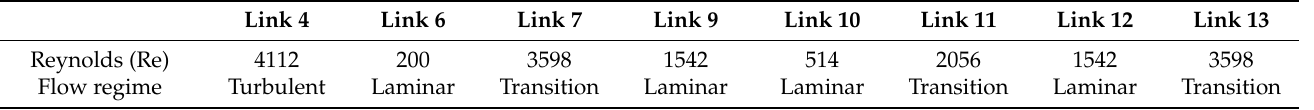
Table 5. Reynolds number and flow